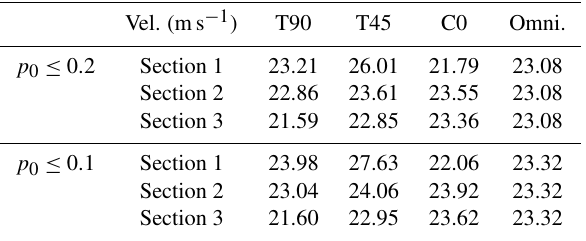
Table 4. Optimization results for criteria T90, T45, C0, and omni- directional analysis for p 0 = 0 . 2 (top rows) and p 0 = 0 . 1 (bottom rows).